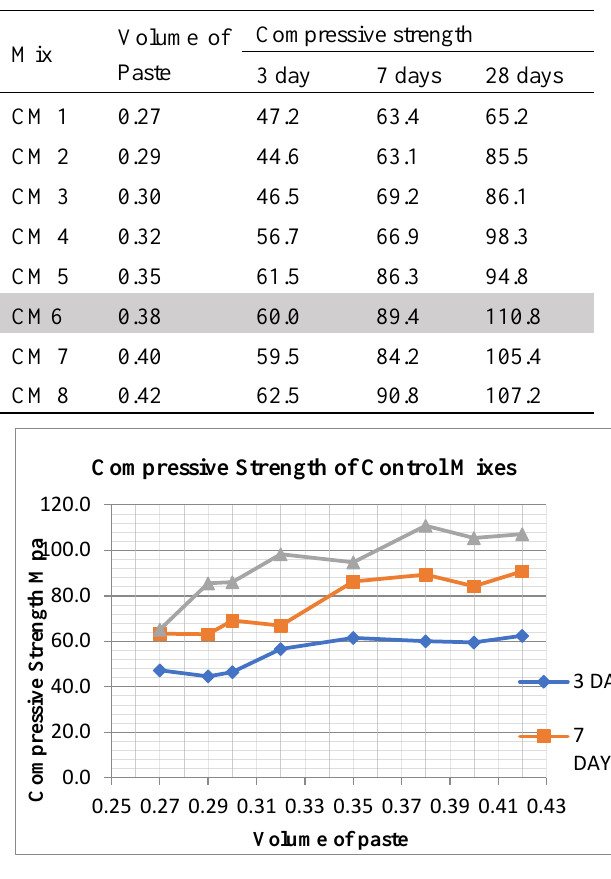
Fig. 12. Compressive strength of control